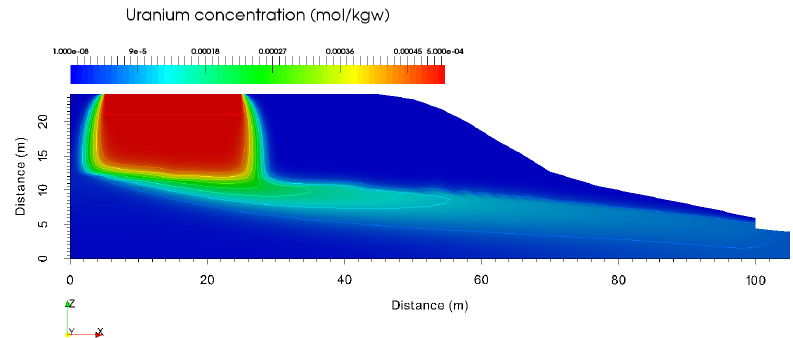
Figure 11. Uranium leaching at a hillslope scale.